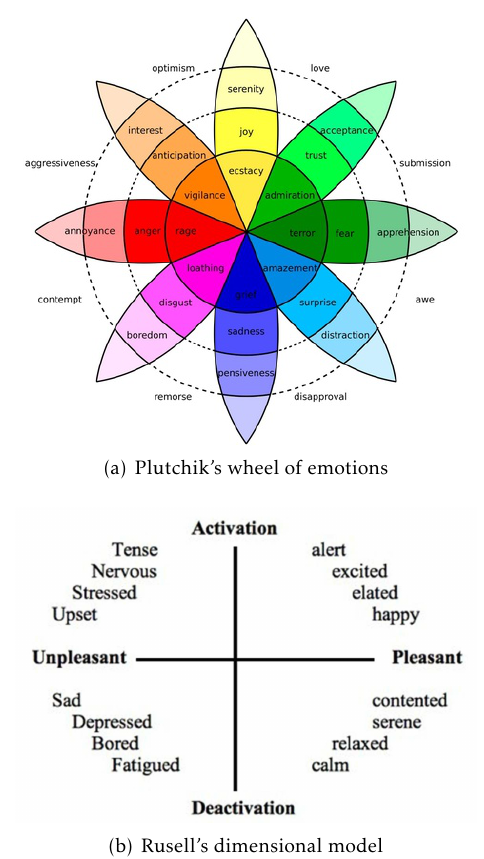
Figure 2. Examples of discrete and dimensional emotion